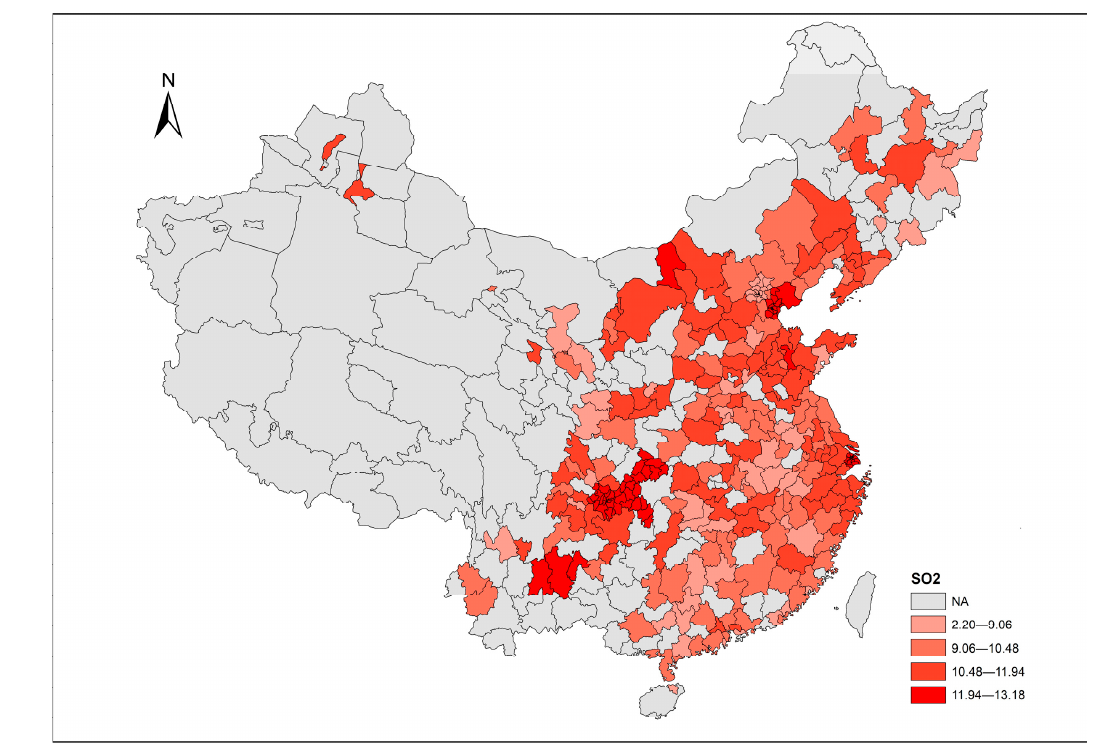
Figure 5. SO 2 emission across cities in 2017. (cid:2870)